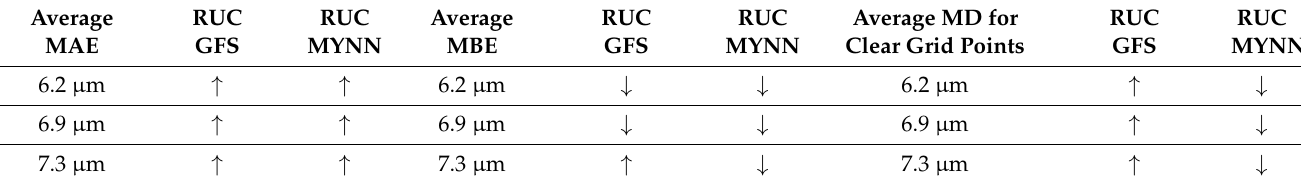
Table 5. As in Table 3 but for a comparison between the Noah land surface model with the GFS surface layer and the RUC land surface model with the GFS or MYNN surface